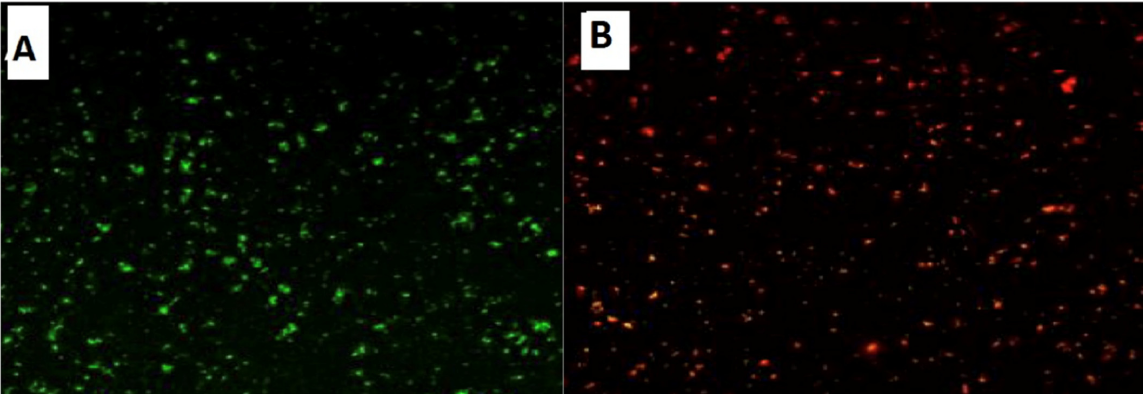
Figure 13. Confocal Scanning Laser Microscopy (CSLM) of mixed species Enterococcus faecalis and Streptococcus mutans ; before ( A ) and after treatment ( B ) with CSNPs.